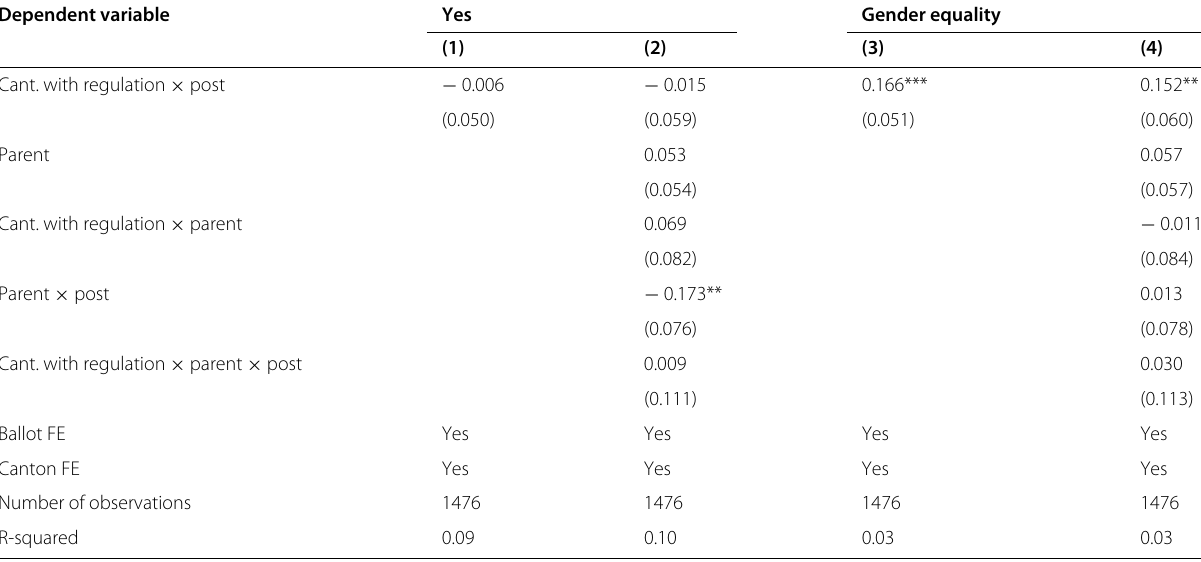
Table 3 DiD estimates using post-vote survey data: effect of lunchtime and after-school care on vote outcomes and attitudes towards gender equality